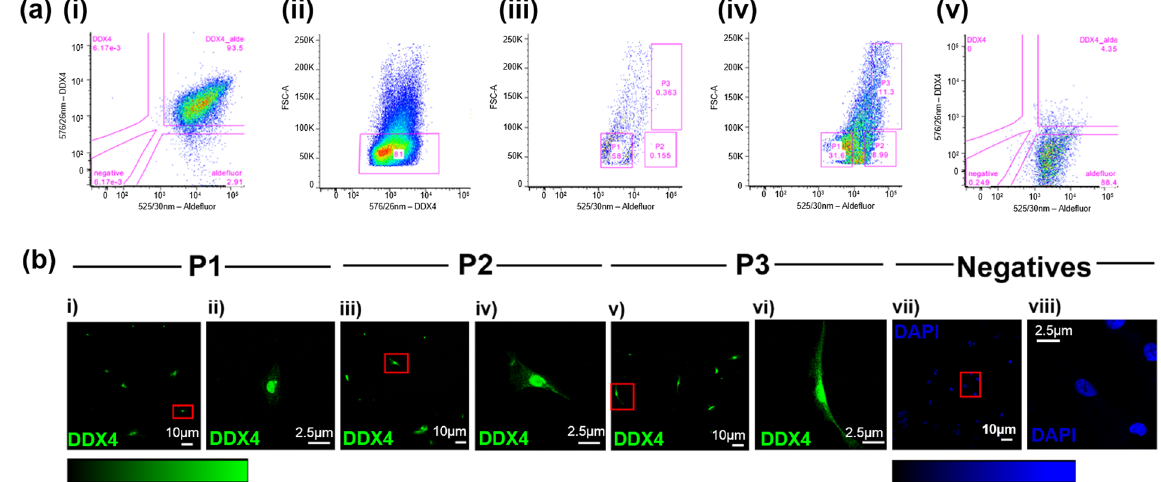
Figure 3. ( a ) Adult human ovarian and rat skeletal cells dual labelled with DDX4 and Aldefluor. Pink lines and boxes denote gates as indicated. Sorting and analysis utilise the same FSC, SSC and singlet gating strategy as previous sort. (i) Human ovarian cells dual labelled with DDX4 (em.576/26 nm) and Aldefluor (em.525/30 nm– 93.5% of the total DDX4-positive sample). (ii) The size distribution of DDX4-positive cells indicate > 80% have a mean diameter of ~8 µ m. (iii) DDX4-positive sample stained with Aldefluor and quenched by DEAB. Sort gates applied to DDX4-positive cells with reference to cell size (FSC) and Aldefluor intensity. (iv) Sub-populations of sorted human ovarian cells (P1, P2 and P3) dual-labelled with DDX4 and Aldefluor. P1 and P2 represent the smallest cells with the P2 population demonstrating higher ALDH1 activity than P1 (8.99% of total DDX4-positive Aldefluor positive cells). (vi) Rat muscle cells was used as a negative control for DDX4 and to show a single emission profile of Aldefluor (em.525/30 nm–88.4% of the total sample). ( b ) DDX4 immunostaining of the DDX4 positive, P1, P2 and P3, and negative sorted cells. Positive staining (green) is observed in each population of DDX4 positive sorted cells P1 (i,ii), P2 (iii,iv) and P3 (v,vi). There was no DDX4 fluorescent signal detected in the negative cells (vii and viii). DAPI was used to stain the nuclei of these cells (blue) for visualisation. Linear LUTs present underneath the images. X20 magnification, scale bar, 10 µ m (zoomed image, 2.5 µ m).